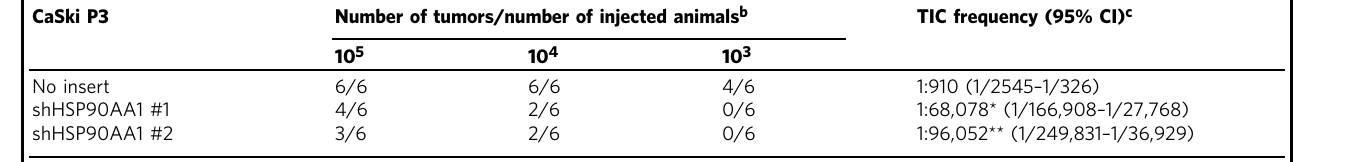
Table 1 TIC frequency of CaSki P3-no insert, CaSki P3-shHSP90AA1 #1, and CaSki P3-shHSP90AA1 #2 cells a . CaSki P3